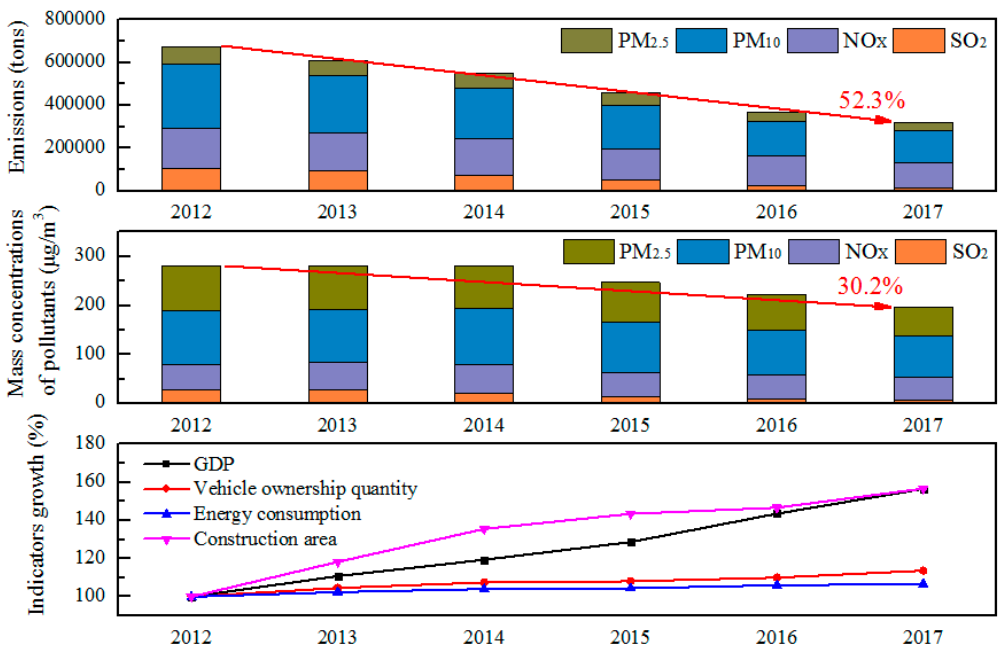
Figure 5. Variations in economic and social development, air quality and emission in Beijing from 2012 to 2017.